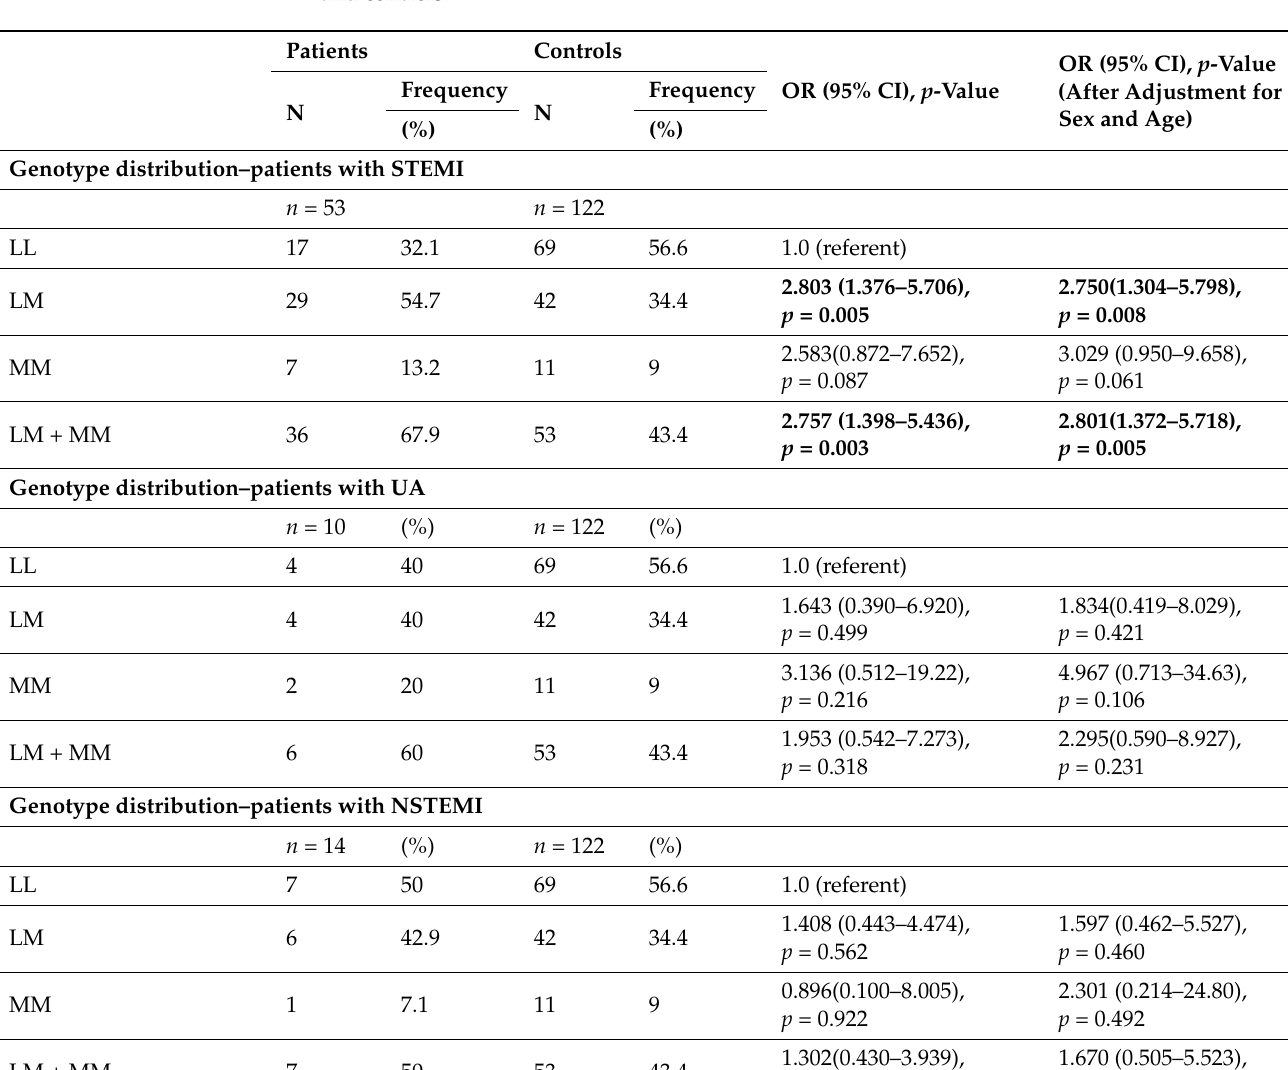
Table 4. Genotype and allelic distribution of L55M in PON1 in patients with different diagnosis and